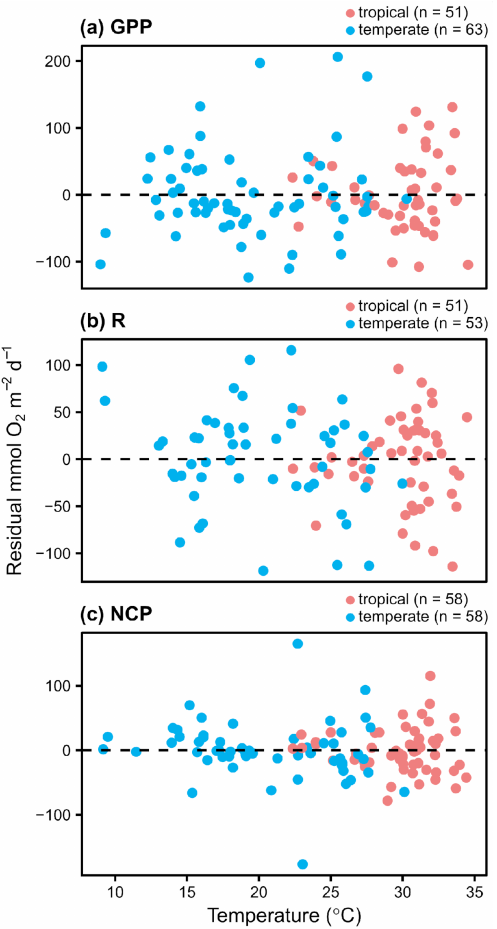
Figure 4. Conditioned residuals of the daily rates of O 2 fluxes (mmolm − 2 d − 1 ) from a seasonal model as a function of temper- ature. Studies performed in temperate versus tropical ecosystems are illustrated by color (blue is temperate, red is tropical). None of the relationships are statistically